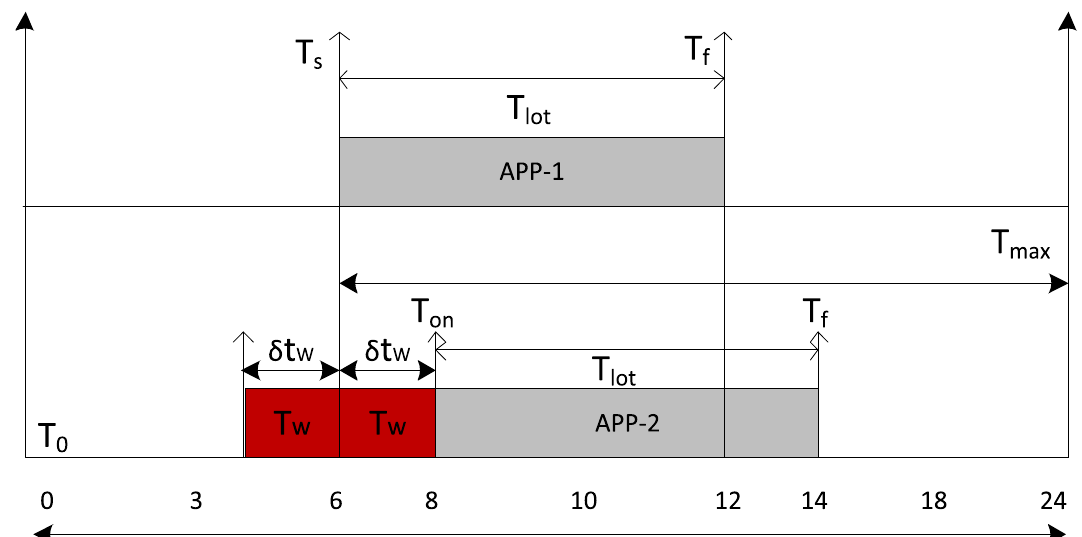
Figure 2. Appliance waiting